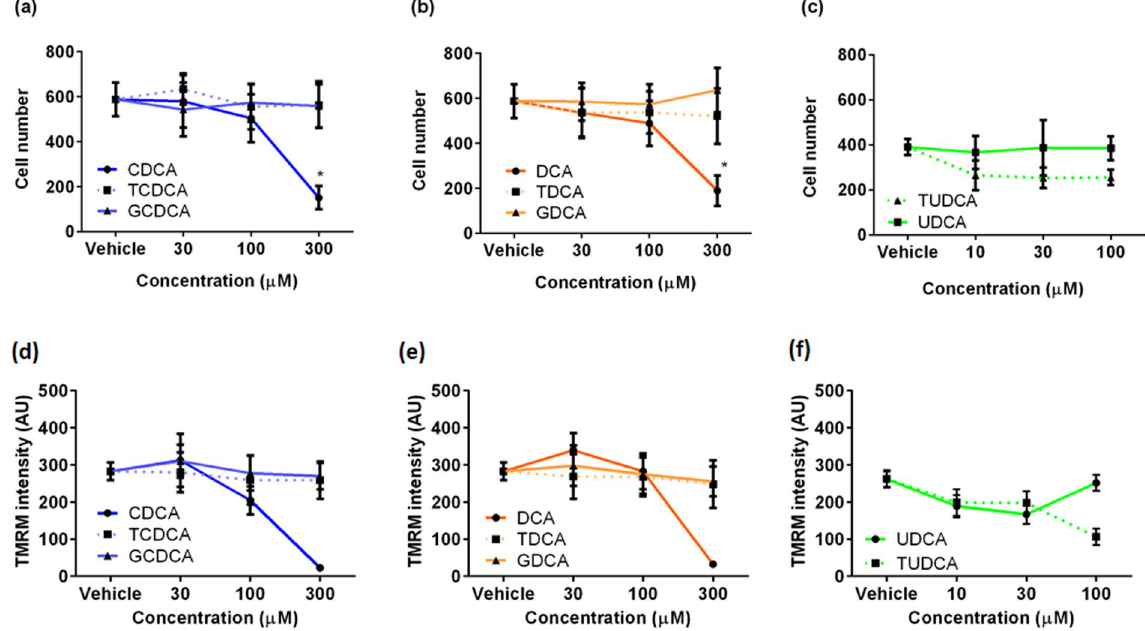
at 30–300 μ M (n = 5, * p < 0.05). Average intensity of TMRM following 24 hours treatment with ( d ) CDCA and conjugates; ( e ) DCA and conjugates; ( f ) UDCA and TUDCA